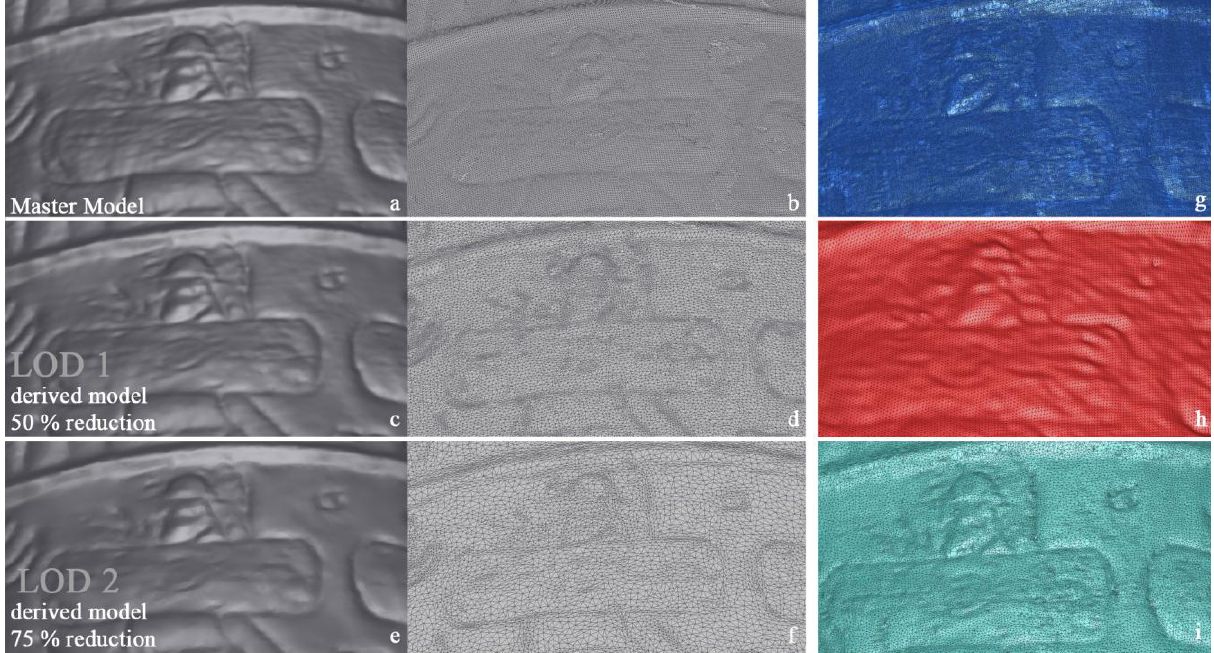
Figure 3. Left, Master Model ( a , b ) and simplified models ( c , d , e , f ) derived using the Perceptron ScanWorks V4i scanner. Right, Master Model acquired using the Perceptron Scan Works V4i ( g , 1100000 faces); ( i ) decimated model derived from g – 80% reduction; ( h ) 3d model acquired using a Minolta Vivid 900 scanner, highlighting the noise due to laser power required in order to measure points location on dark and reflecting surface of the find. h and i have the same number of